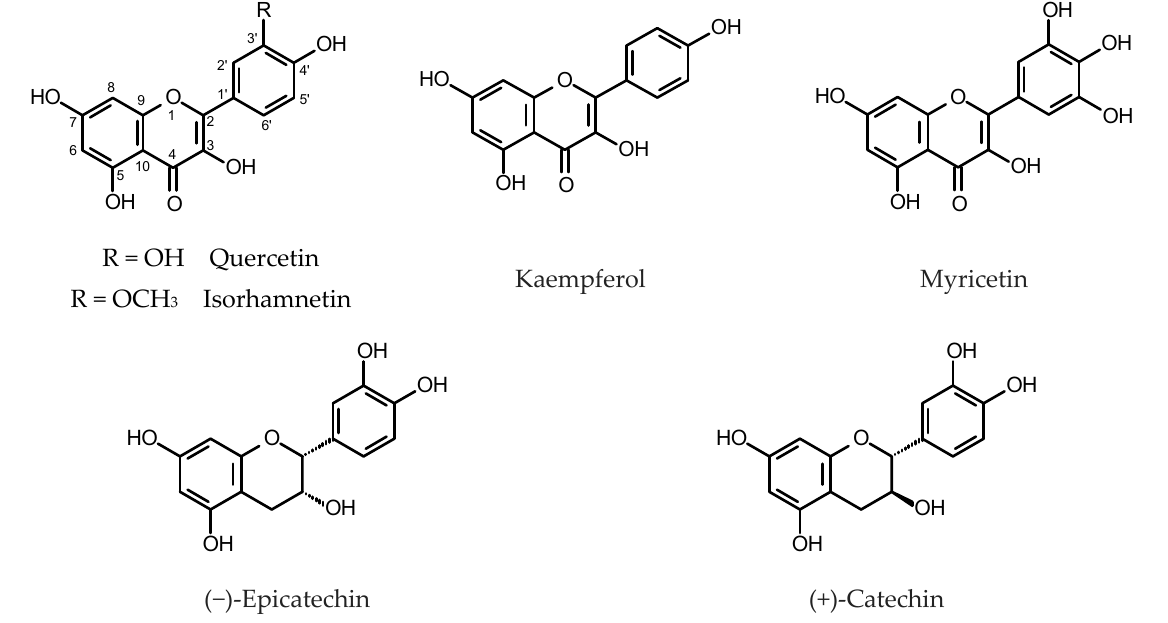
Figure 3. Chemical structures of selected flavonols (upper row) and flavanols. Tusevski and coworkers [68], by means of HPLC-PAD-ESI-MS n , identified and quan- tified numerous phenolic compounds produced by HRs of Hypericum perforatum L. (Hy- pericaceae) obtained by a transformation with R. rhizogenes A4. Flavonols (quercetin 6- C - glucoside, unidentified isorhamnetin- O -hexoside, rutin, kaempferol), flavanol (catechin) and two proanthocyanidin dimers were present in the dark grown roots in small quantities (<1 mg/g DW). Contents of epicatechin and one proanthocyanidin dimer exceeded 1 mg/g DW. The phenolic profile changed when the roots were exposed to light [69]. Selected lines of H. perforatum HRs, transformed with R. rhizogenes A4M70GUS, accumulated up to 4.7 mg/g DW catechin, negligible amounts of procyanidin dimers, and up to 5.9 mg/g DW of quercetin and kaempferol derivatives [70].